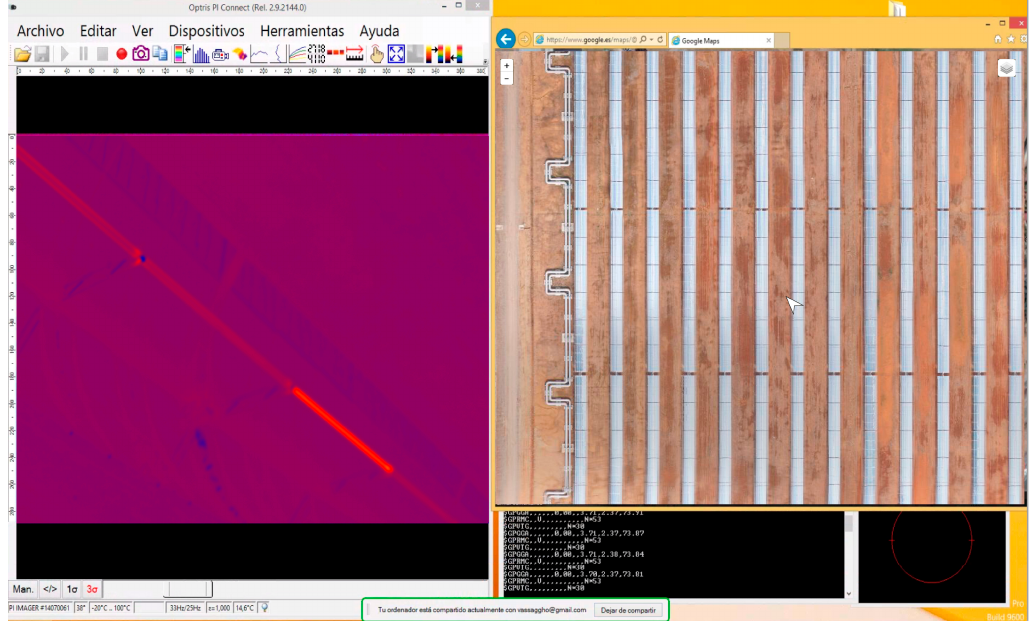
Figure 7. Screen details from Khepri during a thermal inspection on a CSP.